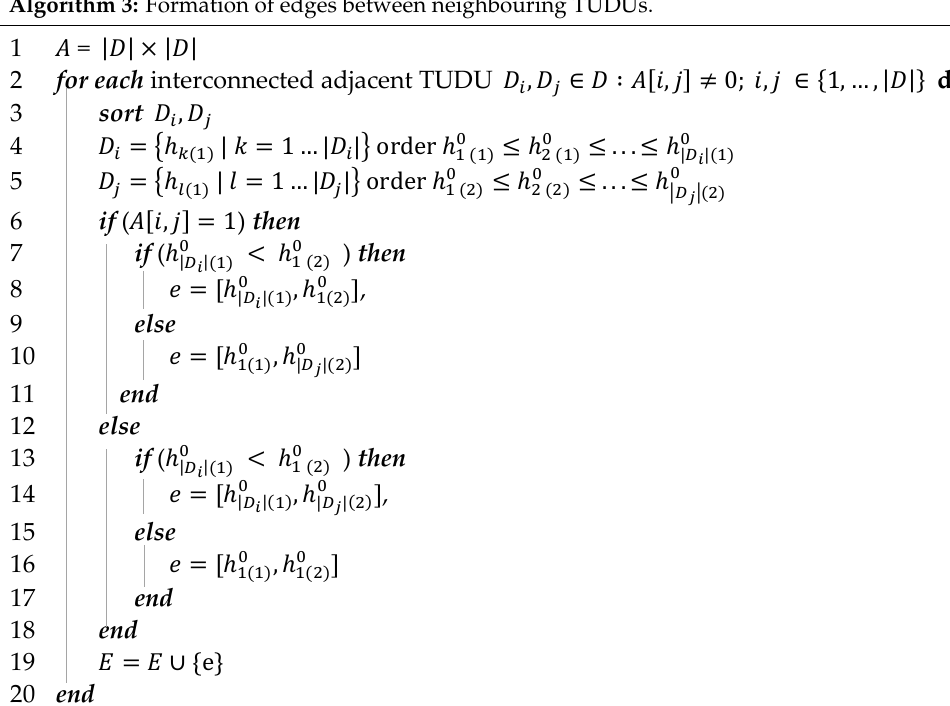
Figure 9. Formation of edges between different TUDUs.